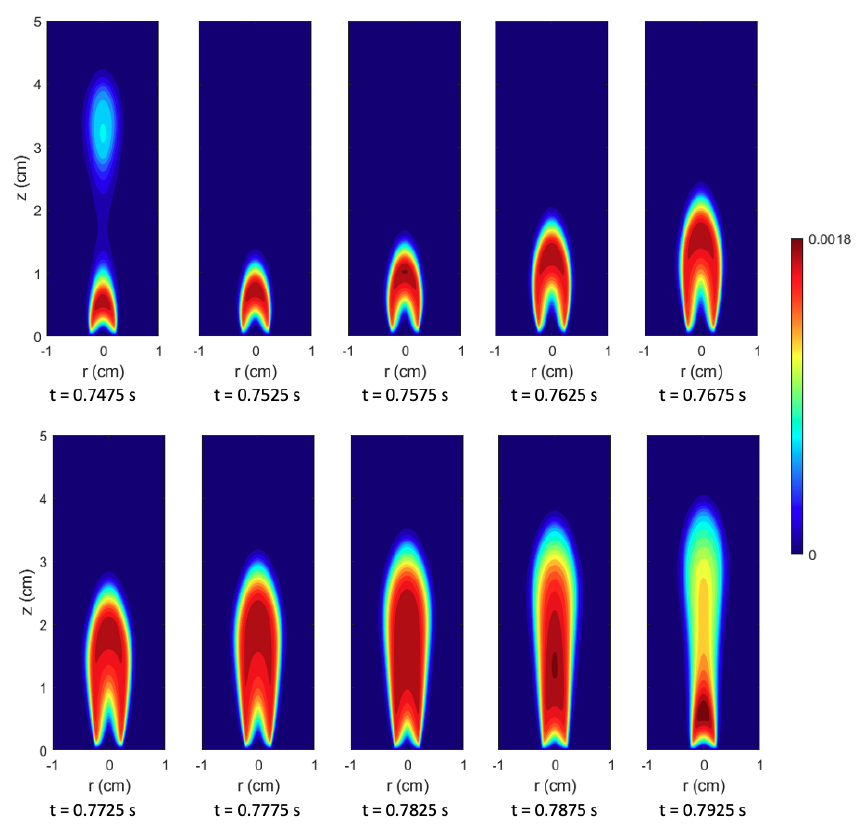
Figure 3. An example of part of the input data: H 2 mass fraction at 10 time steps. The first 9 time steps is the training data while the last time step is the test